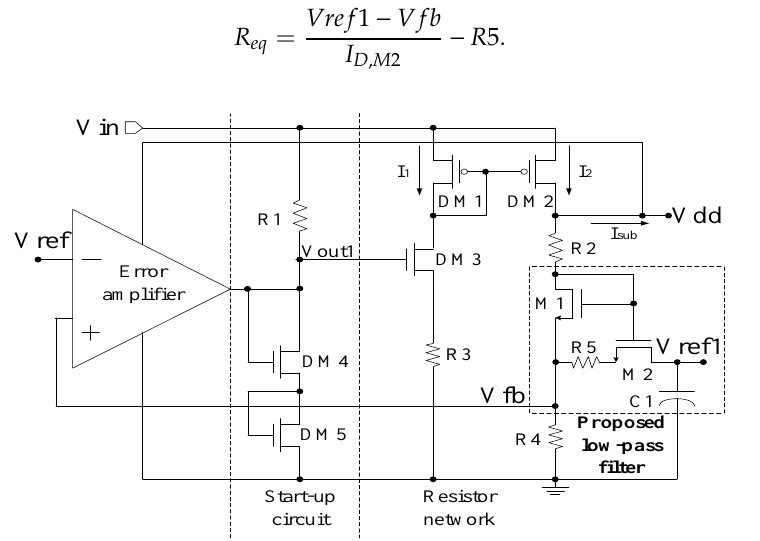
Figure 2. Preregulator with an active low-pass filter.